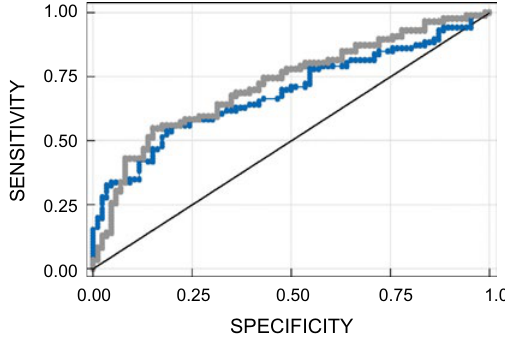
Figure 2: Receiver operator curve of the combined surrogate